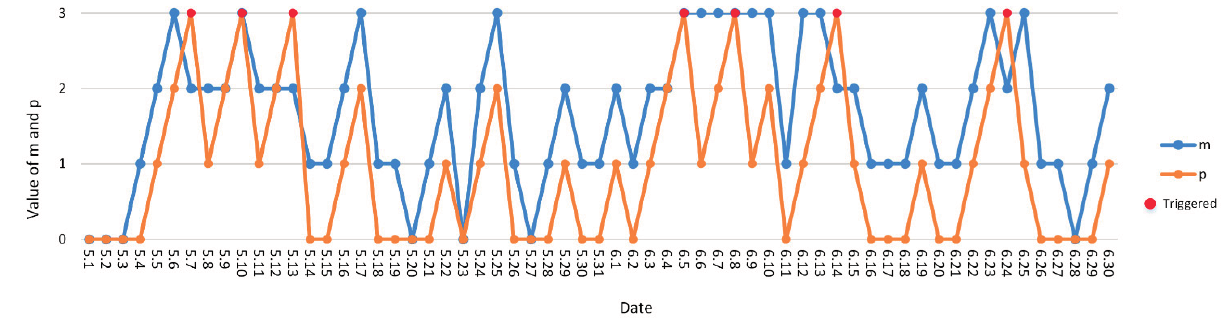
Figure 10. The m and p values of the ASMJ algorithm between May 2014 and June